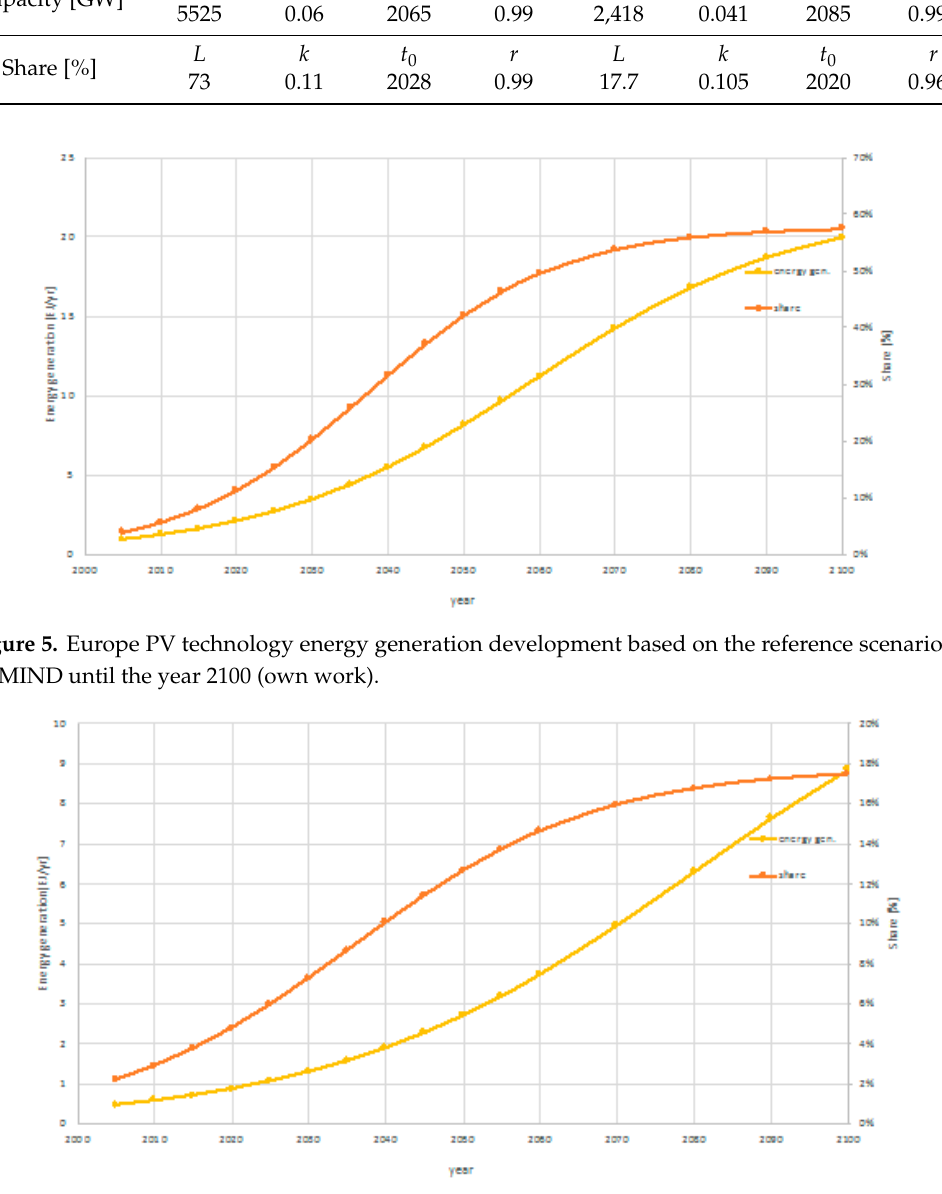
Figure 6. Europe PV technology energy generation development based on the reference scenario of WITCH until year 2100 (own work).